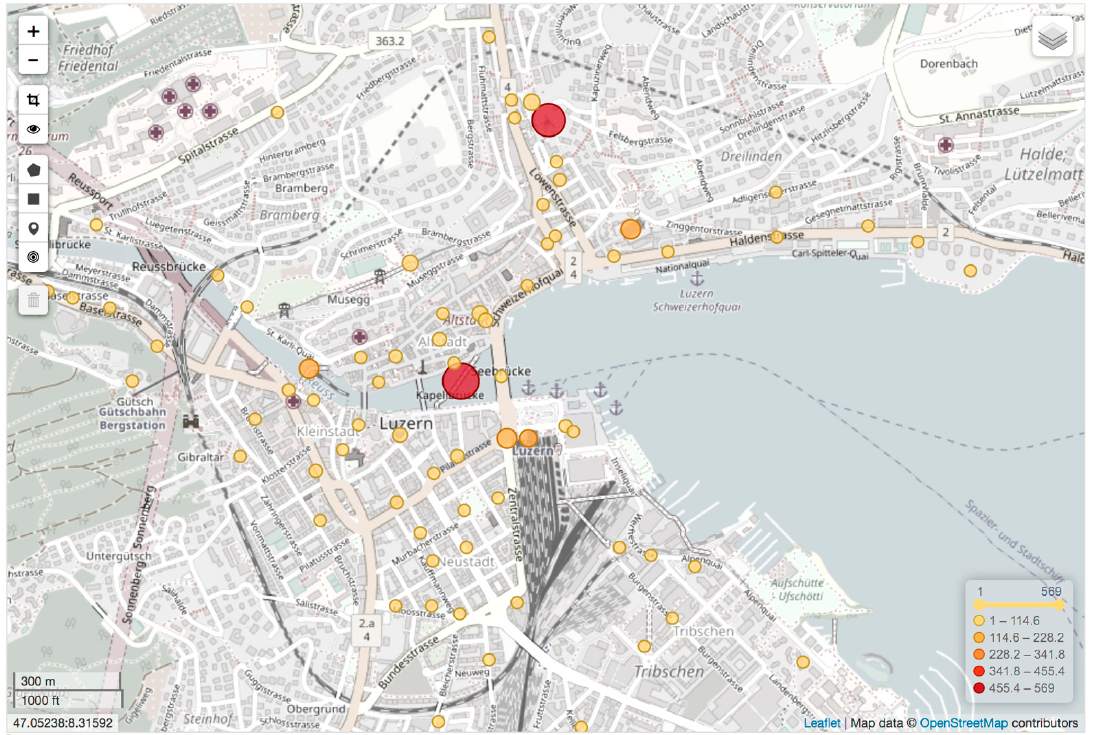
Figure 5. Screenshot: Frequency of comments by users in an interactive heatmap zoomed to the area Figure 5. Frequency of comments by users in an interactive heatmap zoomed to the area of Lucerne. of